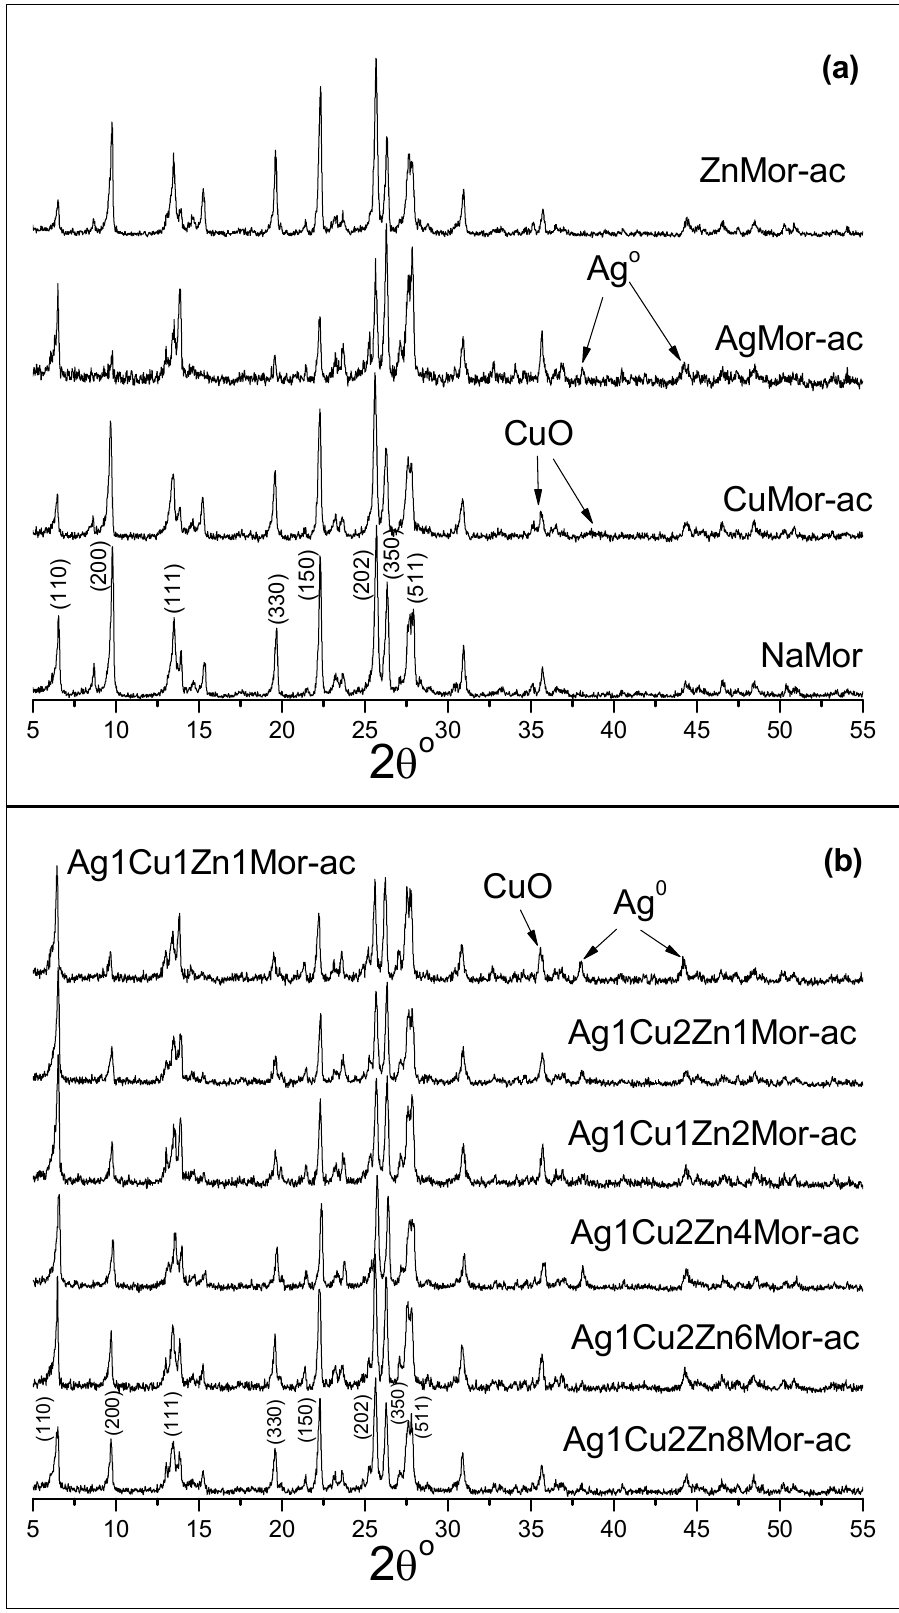
Figure 5. XRD patterns of the samples reduced in hydrogen, followed by cooling in air. The pattern of the NaMor sample is included also.